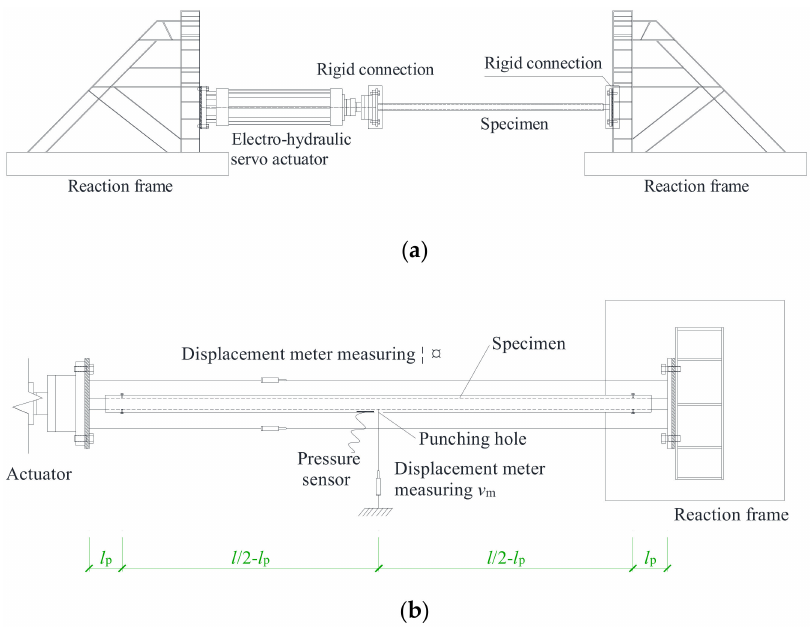
Figure 5. Test setup: ( a ) Loading system; ( b ) measurement